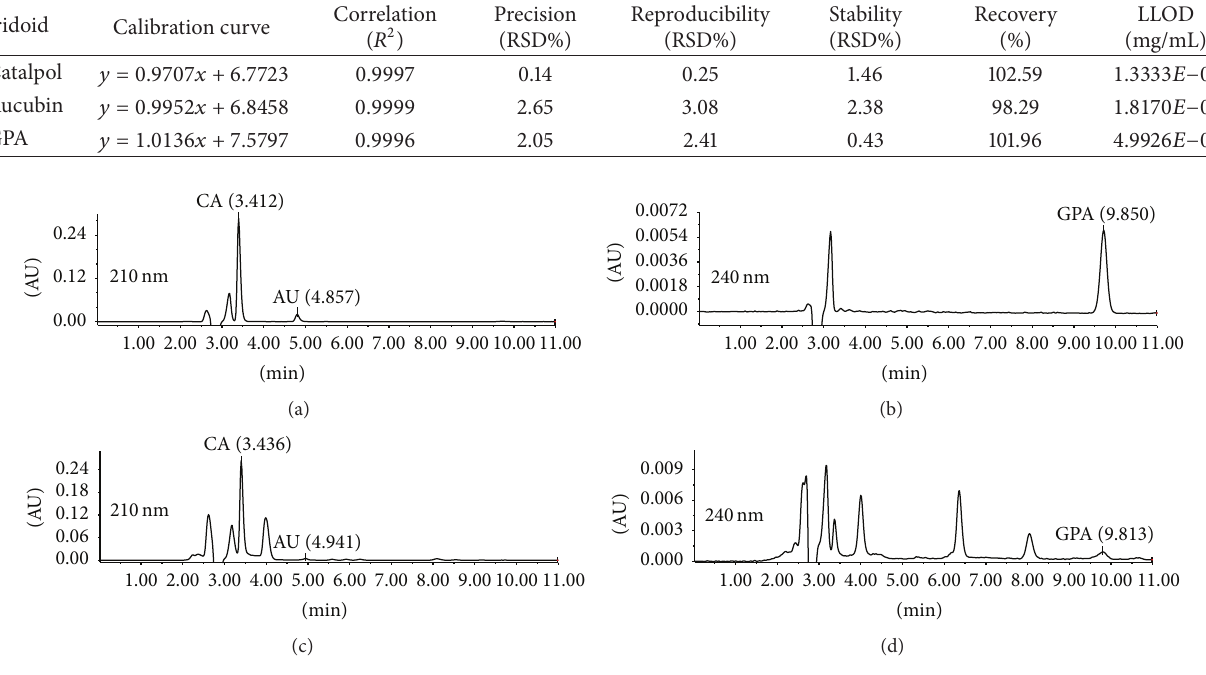
Figure 1: HPLC-UV chromatographs of standard mixture ((a), (b)) and R. glutinosa extract ((c), (d)).